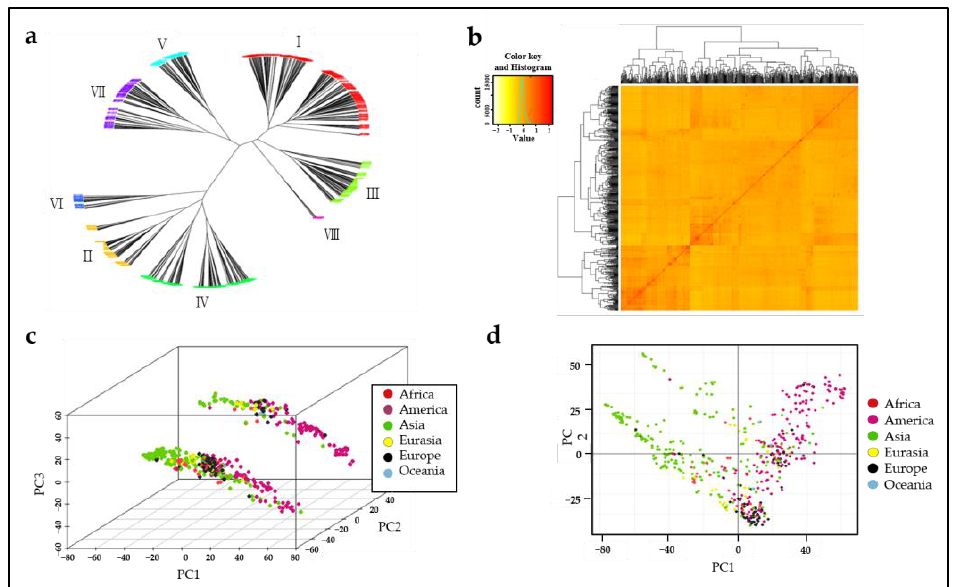
Figure 1. Population structure of the 562 wheat genotype varieties. Kinship is virtually displayed via a neighbor-joining tree ( a ) and a heatmap ( b ). These principal components (PC) are virtually displayed in three dimensions ( c ) and two dimensions ( d ). The different colors represent the six populations.